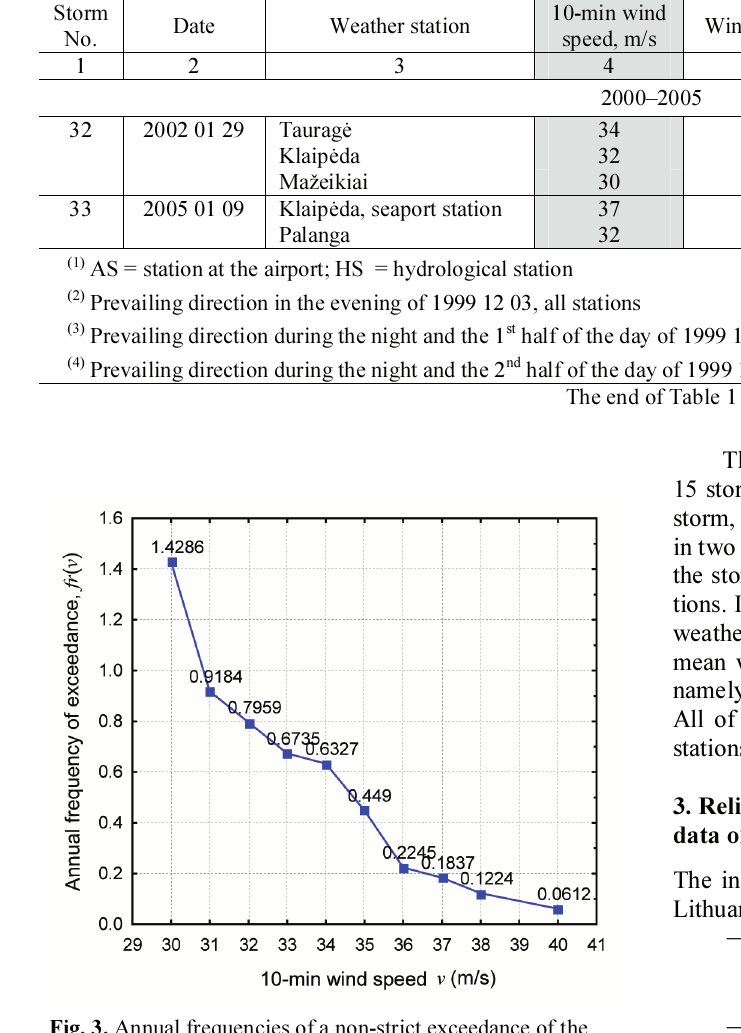
Fig. 3. Annual frequencies of a non-strict exceedance of the wind speed v calculated for the period 1962 to 2009